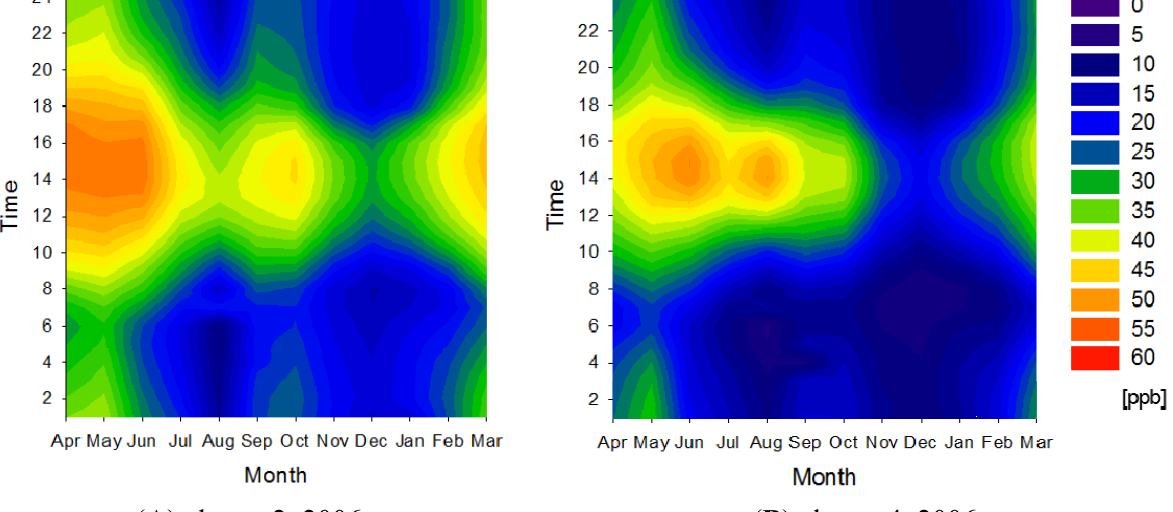
Figure 5. Results of clustering using O